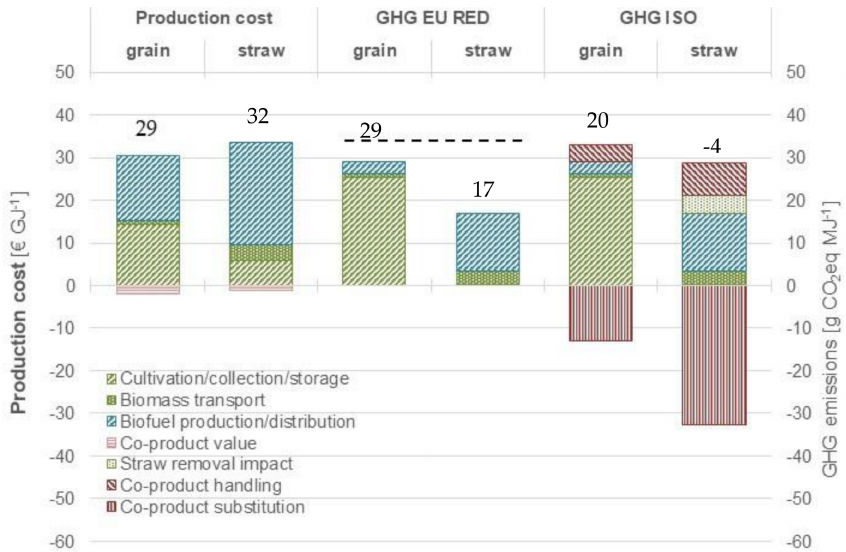
Figure 4. Production cost and emissions for biogas produced in PR1 calculated according to the methods in the EU RED and the ISO standard. The dotted line indicates maximum GHG emissions for new installations according to the EU RED. Numbers above the columns indicate net